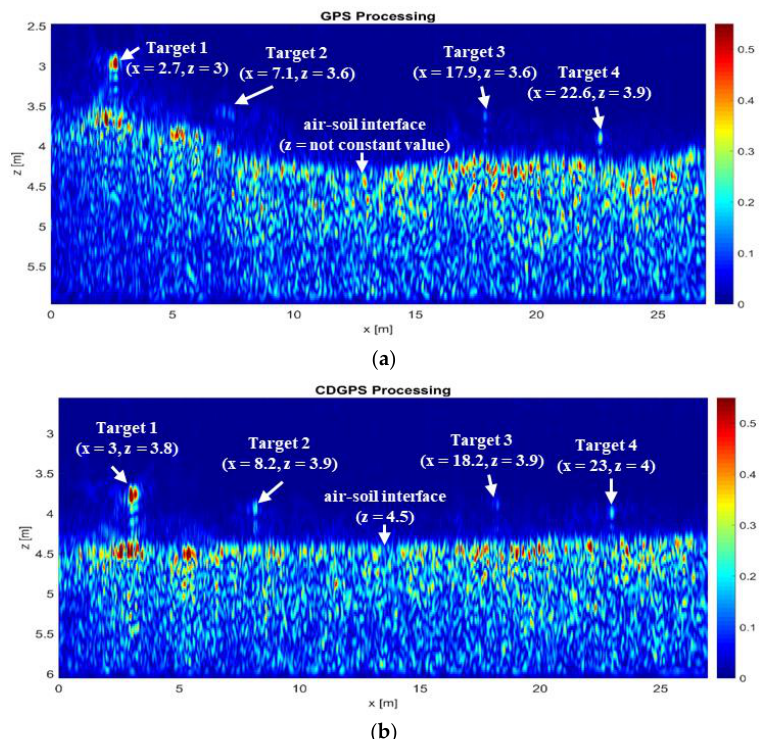
Figure 16. Tomographic images Test 2-Track 1 obtained by Shift and Zoom TSVD algorithm: ( a ) GPS based MoCo; ( b ) CDGPS based MoCo. Remote Sens. 2020 , 12 , x FOR PEER REVIEW